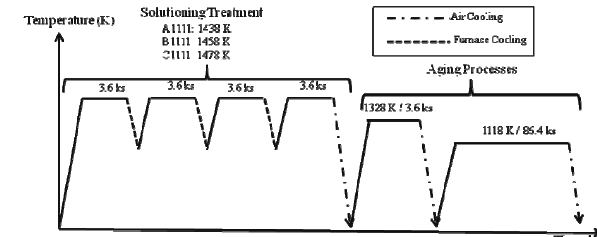
Figure 12. Simulated reheat treatment programs: A1111, B1111 and C1111.